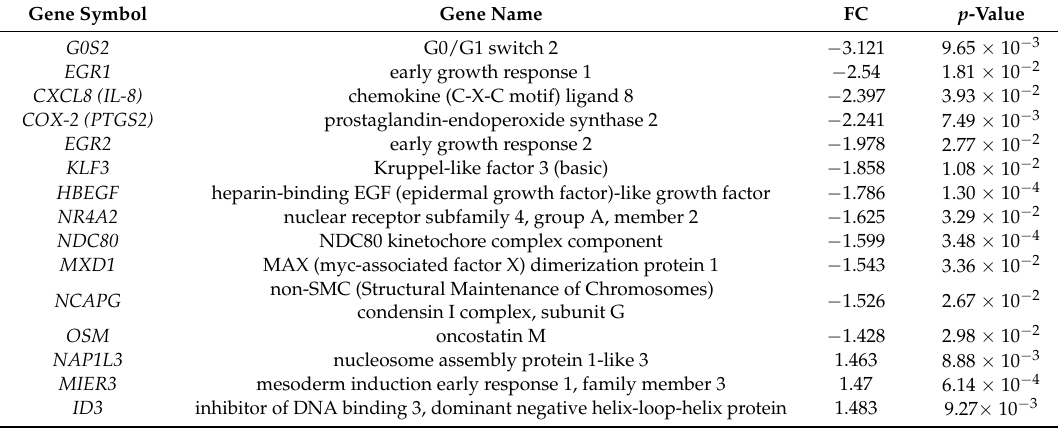
Table 1. Fold change (FC) in gene expression after olive leaf extract (OLE) supplementation relative to placebo (PBO) with p -values.